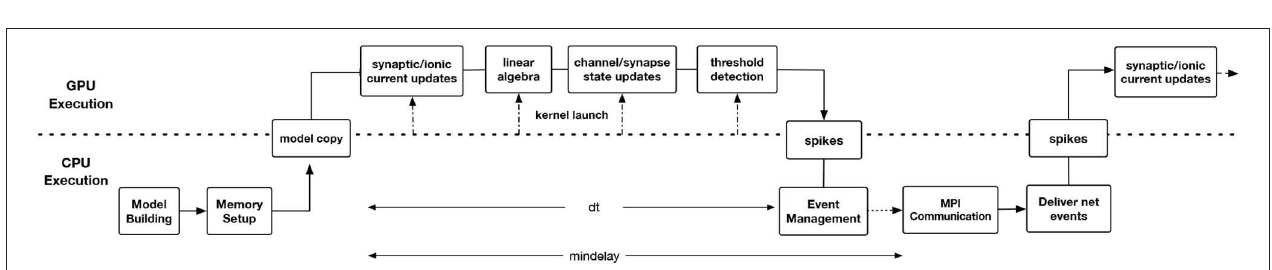
FIGURE 4 | Code generation workflow for CoreNEURON : different phases of the source-to-source compiler are shown in the middle that translates the input model description file (hh.mod) to C++ code (hh.cpp). Compiler hints like ivdep and acc parallel loop are inserted to enable CPU vectorization/GPU parallelization.